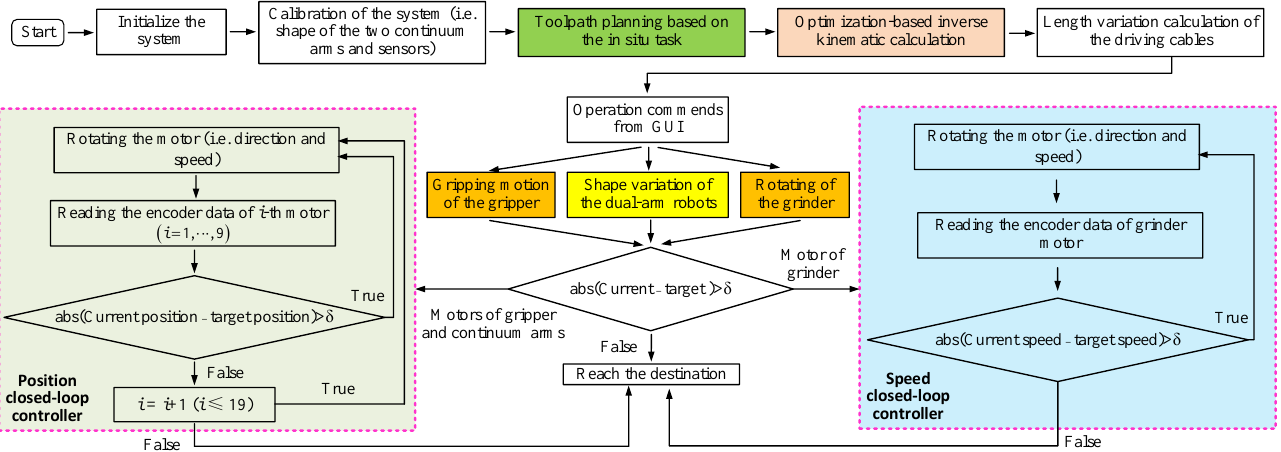
Figure 13. Flowchart of the collaborative operation strategy for the dual-arm continuum robot system.